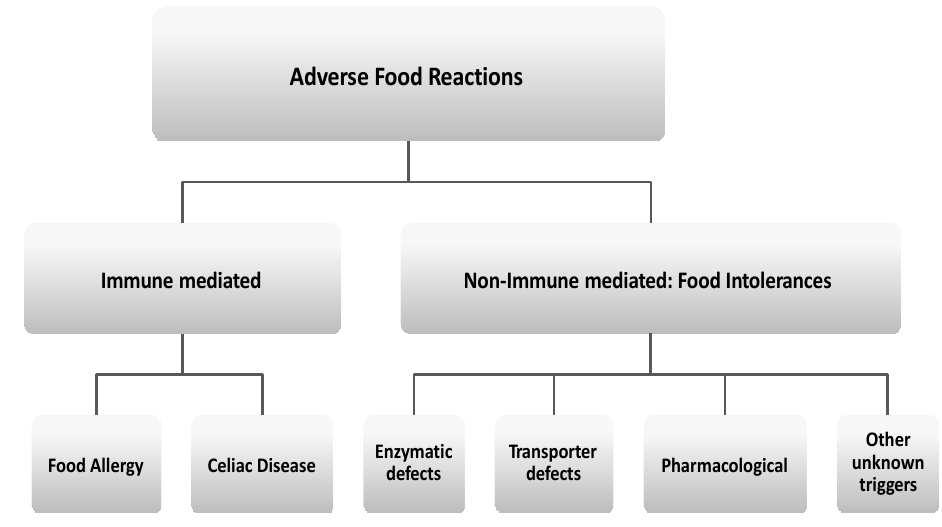
Figure 1. Classification of adverse food reactions (AFR).